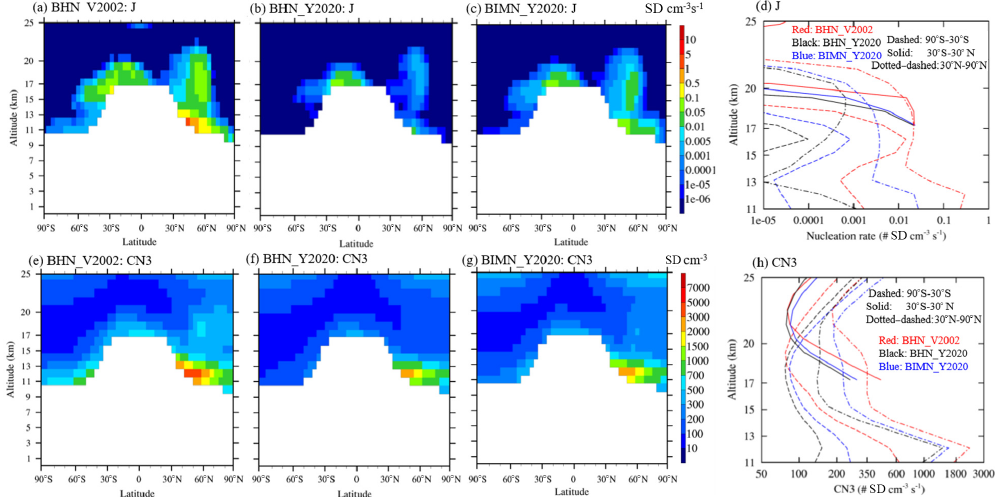
Figure 3. Model-simulated zonal mean and vertical profiles of nucleation rates ( J , upper panels) and number concentrations of particles larger than 3nm (CN3, lower panels) in the stratosphere during the 2-year period covering ATom 1–4 (June 2016–May 2018), based on three nucleation schemes ( a, e : BHN_V2002, b, f : BHN_Y2020, and c, g : BIMN_Y2020). The vertical profiles in panels (d) and (h) are averaged for three latitude zones (90–30 ◦ S, 30 ◦ S–30 ◦ N, and 30–90 ◦ N). The values for those grids with at least 50% of time above the tropopause are shown.